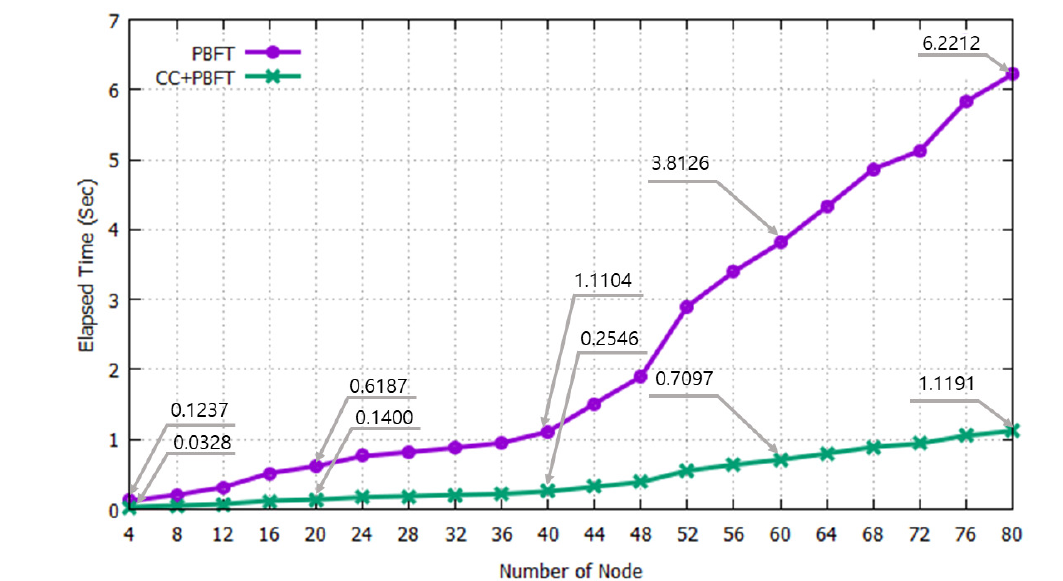
Figure 4. Elapsed time comparison between PBFT and PBFT equipped with the Consensus Coordinator